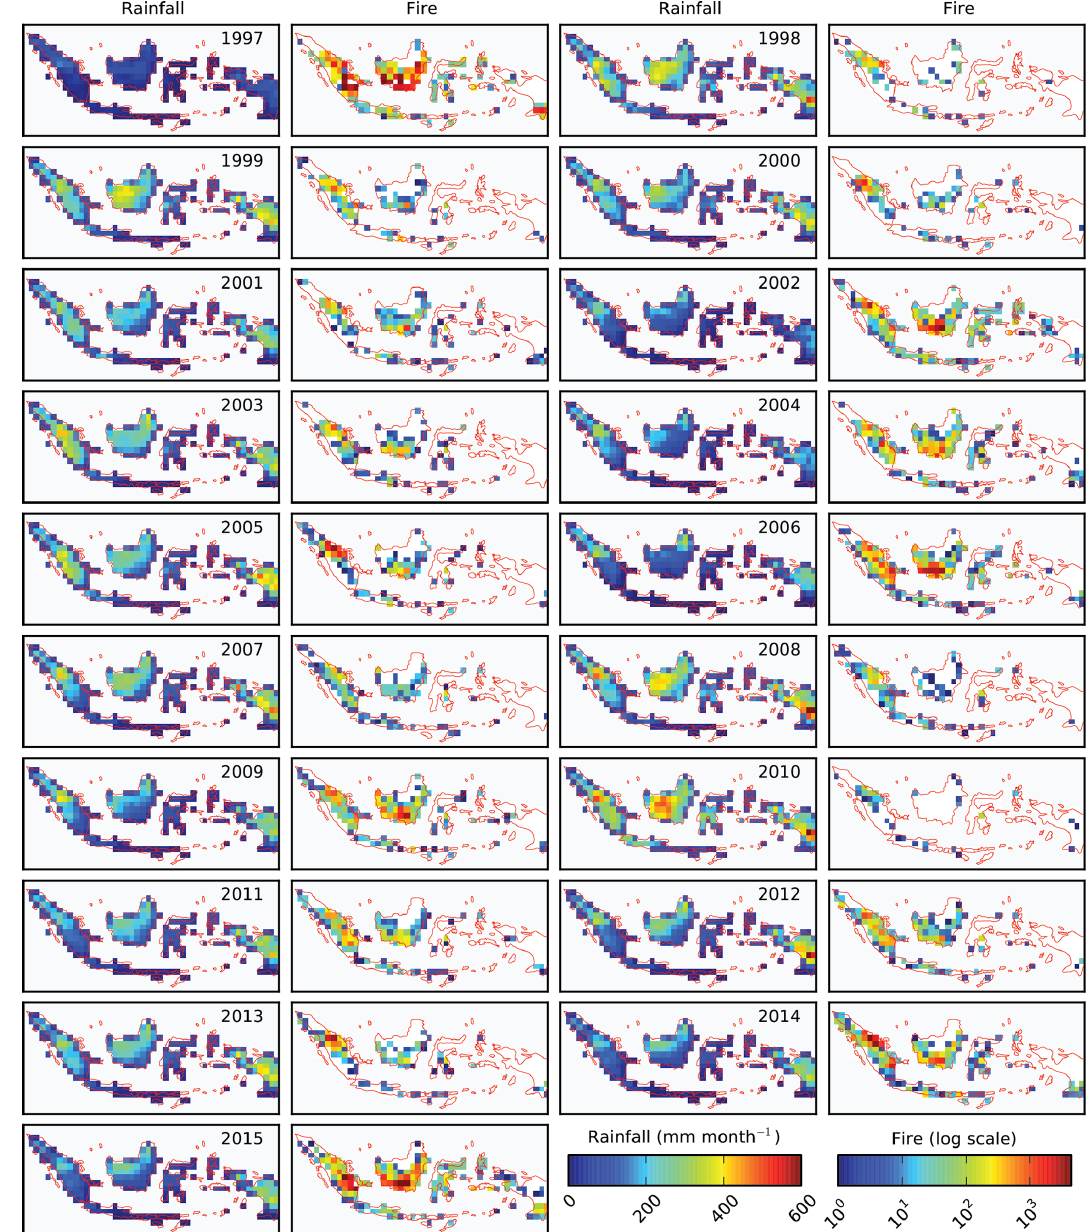
Figure 7. Rainfall and active fire detections (log scale) aggregated to 1 ◦ spatial resolution during the dry